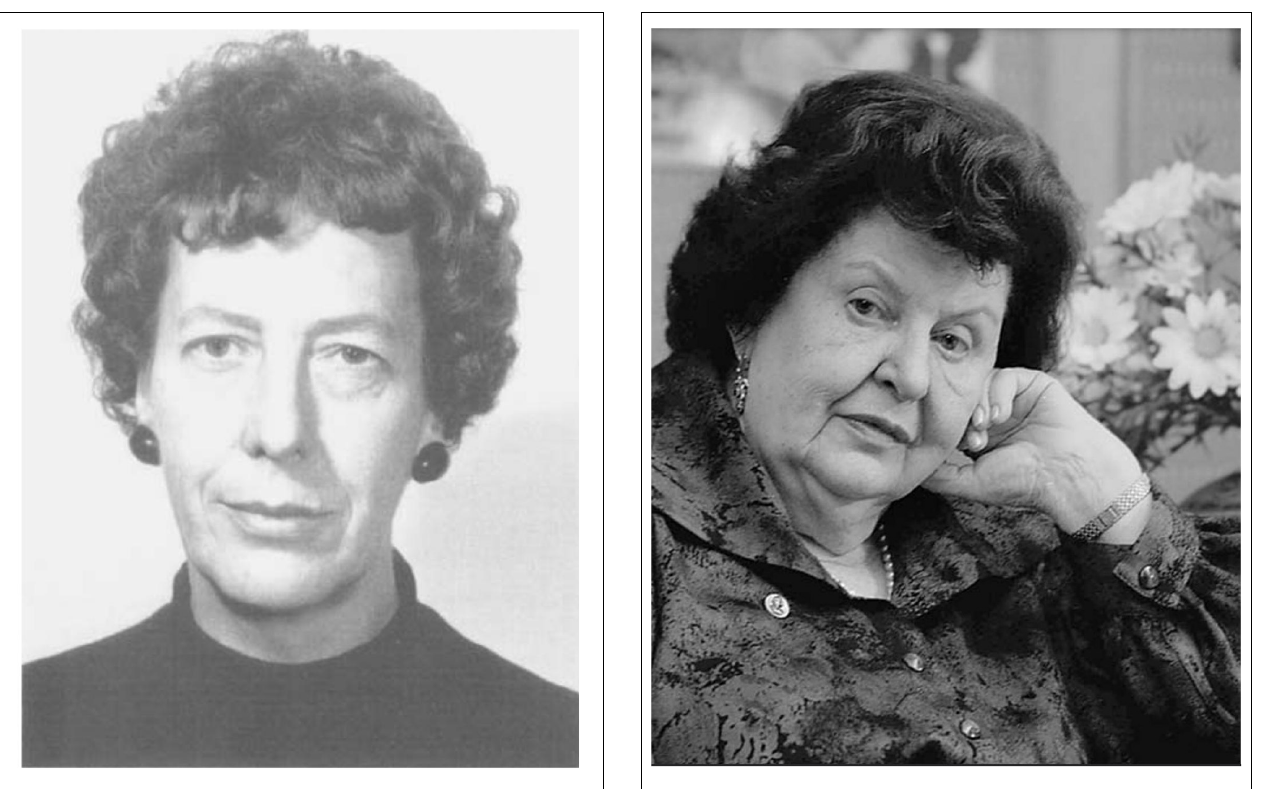
FIGURE 1 | Marion Smith, reproduced from Duchen (1989). FIGURE 2 | Natalia Bechtereva, reproduced from Anonymus